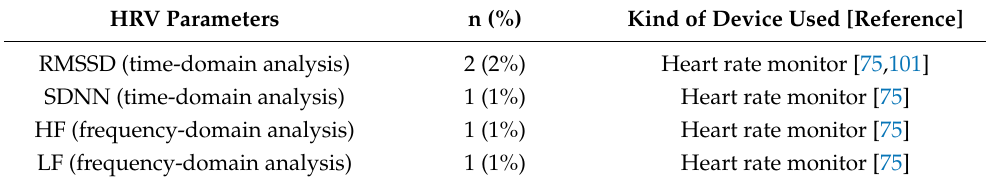
Table 5. HRV analysis methods (n =